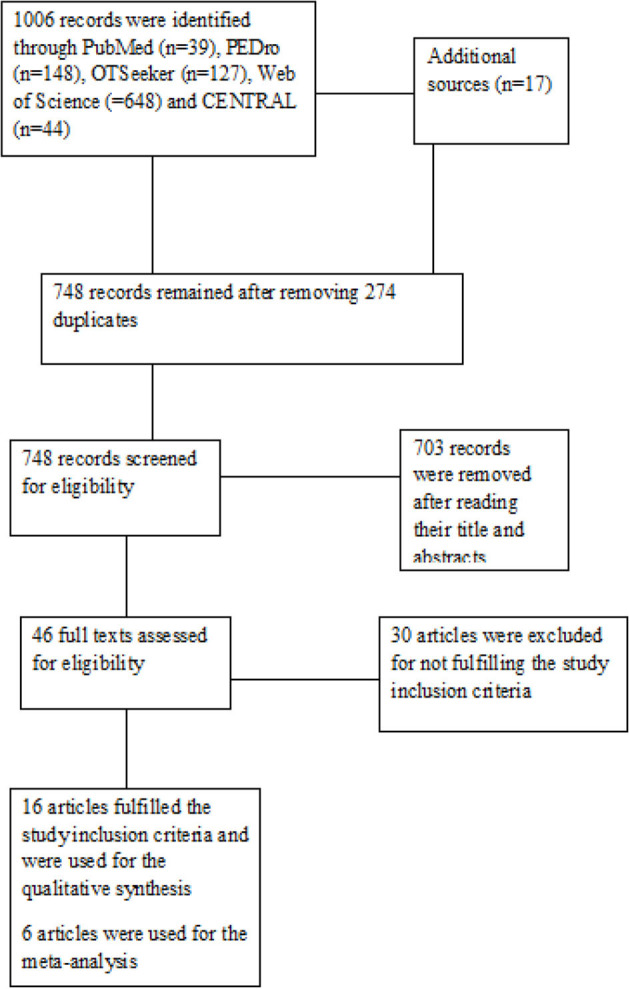
The Study flowchart.